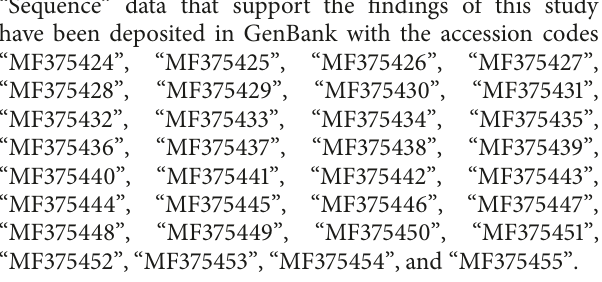
Supplementary 1. Table 1: oligonucleotides sequences that comprise PGMy09 and PGMy11. Supplementary 2. Table 2: sequences generated on the study and their accession numbers on GenBank. Supplementary 3. Table 3: HPV6 and HPV11 sequences